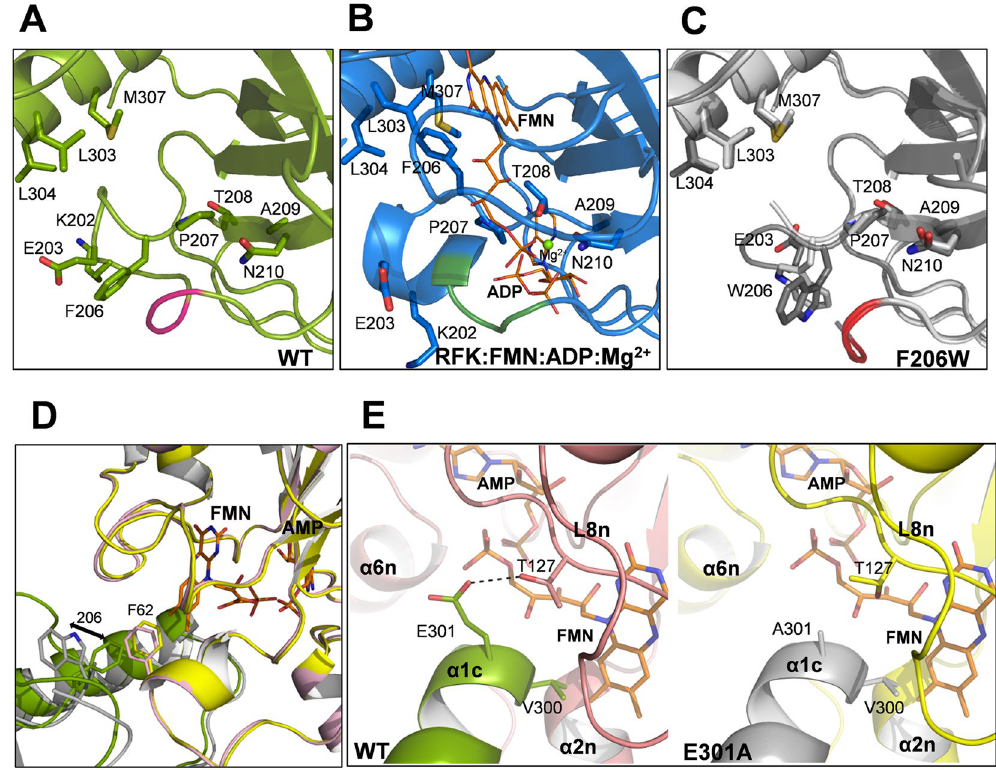
Figure 5. Structural analysis of Ca FADS variants. Detail of the RFK module around the F206 position in ( A ) WT Ca FADS (PDB code: 2x0k) (green), ( B ) the WT Ca FADS ternary complex with the reaction products (PDB code: 5a89) (blue) and ( C ) superposition of the two chains of the asymmetric unit (Chain A in light gray and Chain B in dark gray) in F206W Ca FADS with the two different conformations adopted by W206 (PDB code: 5fnz). Relevant residues are represented in sticks and CPK colored, and residues 197, 198 and 199 of L1c- FlapI are highlighted in pink, green and red, respectively. FMN and ADP ligands of the ternary complex are depicted as narrow sticks with orange carbons and the Mg 2 + ion is shown as a green sphere. ( D ) Superposition of predicted macromolecular head-to-tail interfaces at the RFK and FMNAT modules of contiguous protomers within each trimer in WT Ca FADS (modules in green and pink, respectively) and in F206W Ca FADS (modules in gray and yellow, respectively). Residues 62 and 206 are shown in colored sticks. An arrow indicates the change in side chain conformations at position 206 in the mutant. ( E ) Detail of the predicted trimer head-to-tail interface region around position 301 in WT (left panel, RFK module in green and FMNAT module in pink) and E301A (right panel, RFK module in gray and FMNAT module yellow, respectively) Ca FADS variants. In ( D , E ) FMN and AMP ligands in the FMNAT module have been modelled as previously described and are shown in sticks colored with carbons in orange 6